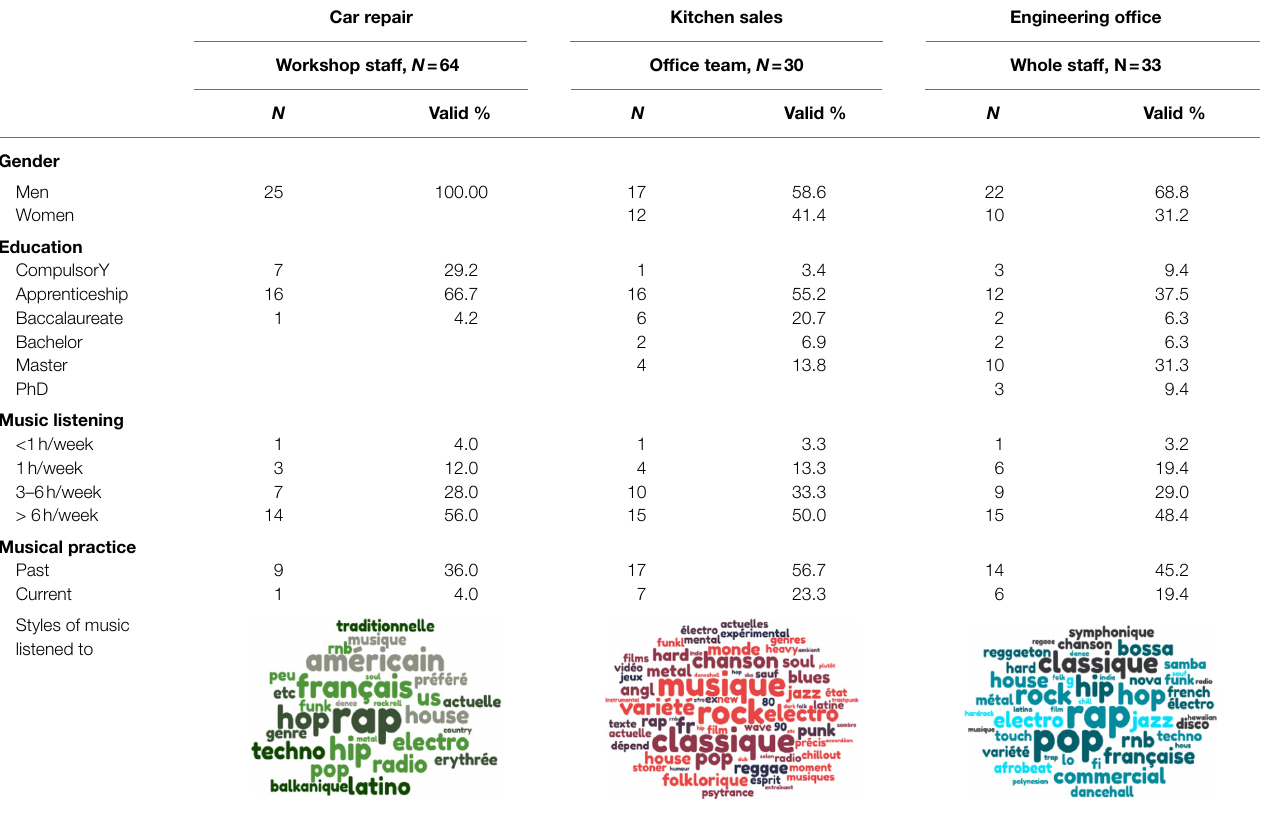
TABLE 1 | Socio-demographic data of the staff who participated in the project. Car